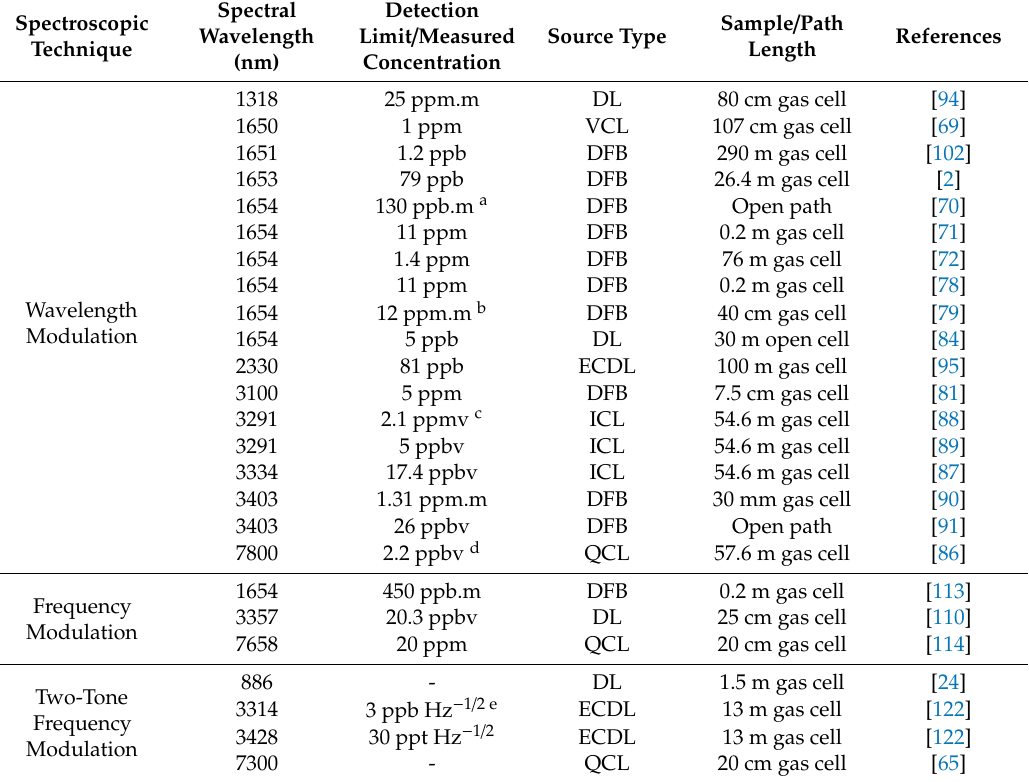
Figure 6. Frame diagram of the CH 4 detection system. Reproduced with permission from [70], Elsevier Science, 2017. Table 2. Methane measurement characteristics for modulation spectroscopy techniques.